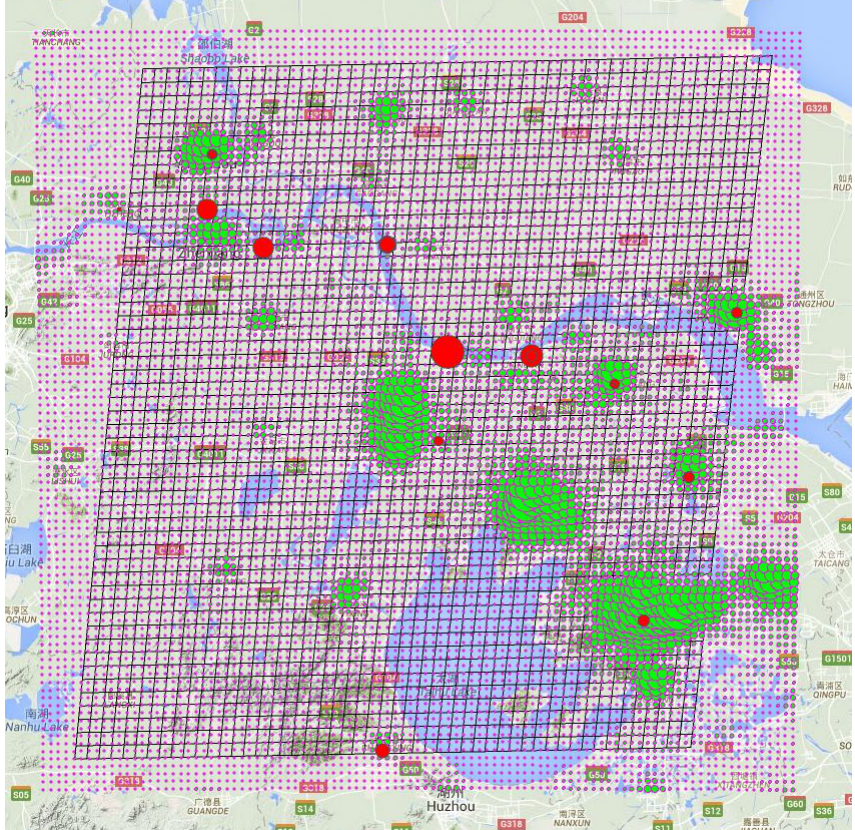
Figure 2. The red dots show the locations of power plants as listed by CARMA (Carbon Monitoring for Action, http://carma.org). The sizes of the dots are proportional to the annual CO 2 emissions of the plants. The green dots are the emissions used in the WRF simulations, redistributed using